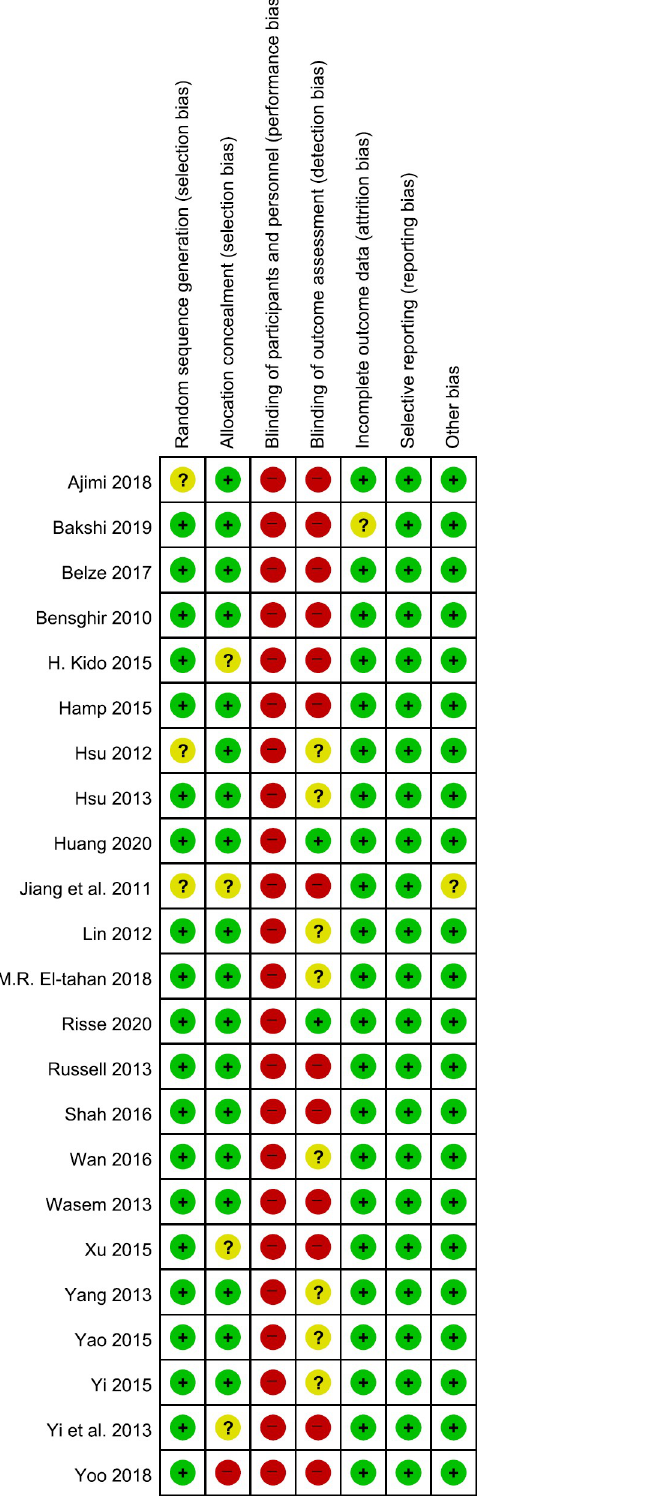
Fig 2. Risk of bias